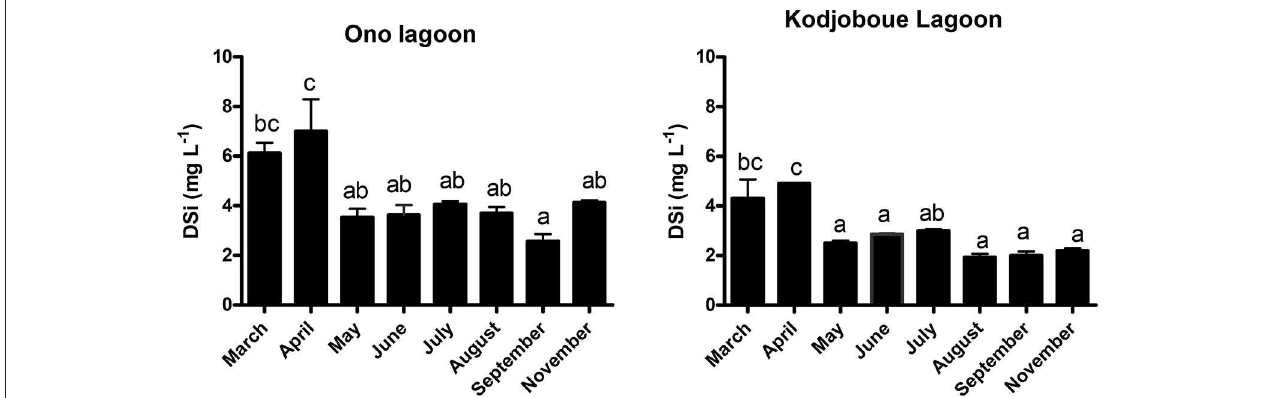
FIGURE 2 | DSi concentrations (mg L − 1 ) in the water column of Ono and Kodjoboue lagoons. Data represent averages of different sample points ( n = 3) and error bars indicate standard deviation. Different letters indicate a significant difference ( p <